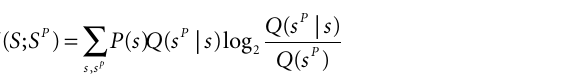
Figure 5 | The dependence of information obtained by decoding the activity of one column on stimulus time uncertainty Y . The information about whether whisker D1 or D2 was deflected, obtained by the summed counts (red line) or the latency of synchronous population activity (black line) of a population of neurons located in a single column (barrel D2). The information is computed in a time window of duration 50 ms starting Y ms before stimulus